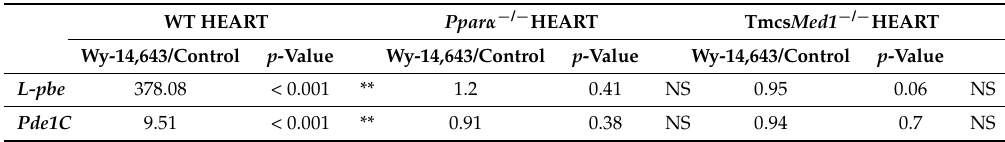
Table 2. Increase in Pde1C mRNA levels in WT hearts upon Wy-14,643 treatment is dependent on PPAR α and